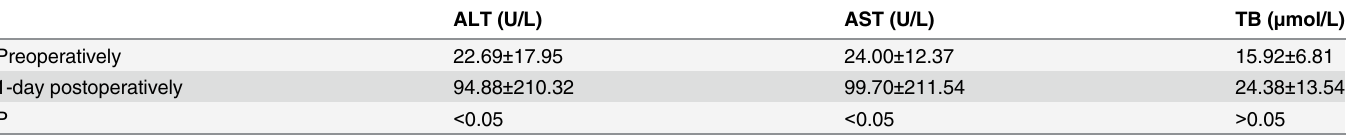
Table 3. Comparison of preoperative and 1-day postoperative liver function of 26 patients with giant hepatic hemangioma.